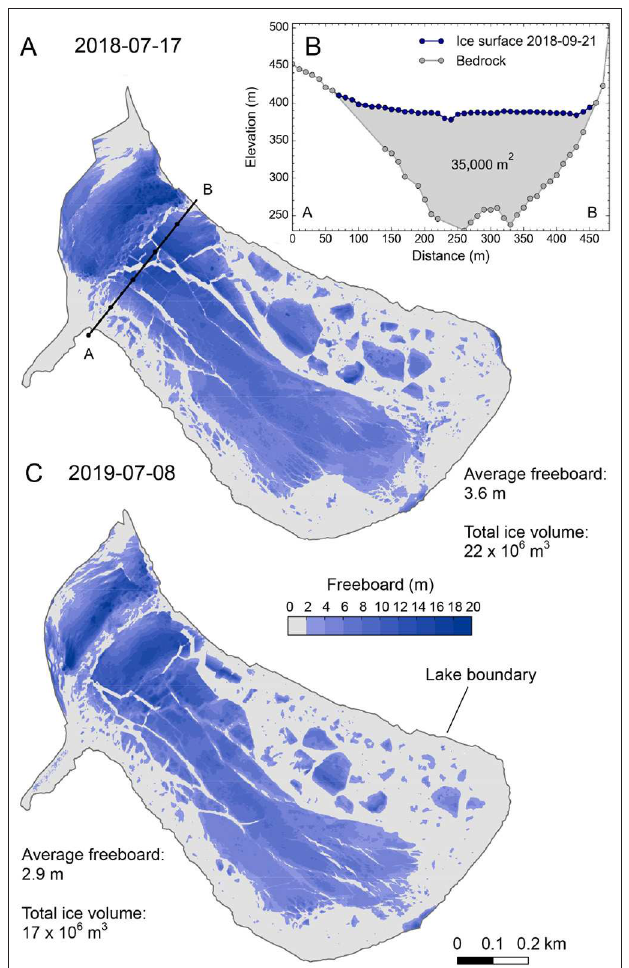
FIGURE 15 | (A) Iceberg freeboard on 17 July 2018, calculated by subtracting the water level (441.5 m) from the DEM elevation. The annotated average freeboard elevations and ice volumes apply to the basin area beyond transect A–B. (B) Bedrock elevation across the basin entrance estimated by subtracting ice thickness estimates from 17 July 2018 (floating stage) from the ice surface measured on 21 September 2018 (grounded stage). Gray dots indicate location of the used ice thickness estimates. Gaps indicate areas with open water or overturned icebergs where freeboard measurements are not available/meaningful. (C) Same as (A) , but for 8 July 2019 (water level 438.2 m).